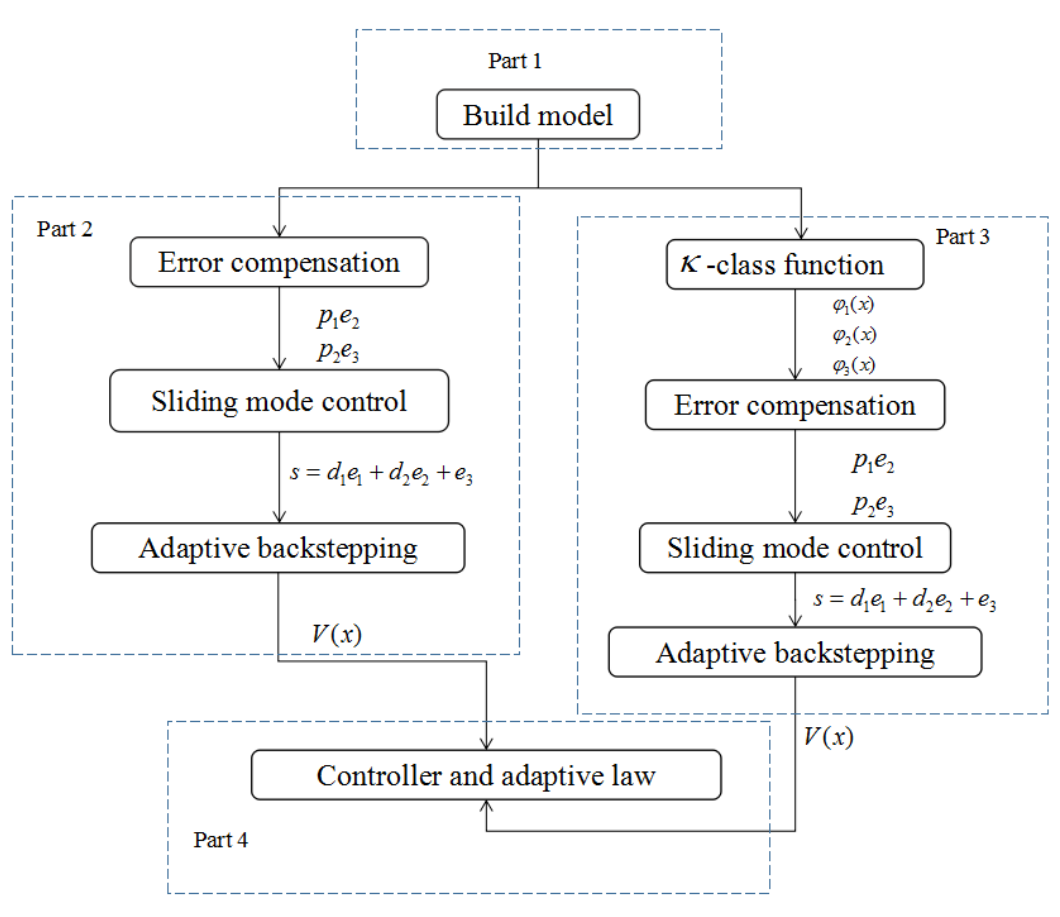
Figure 2. The structure diagram of SVC